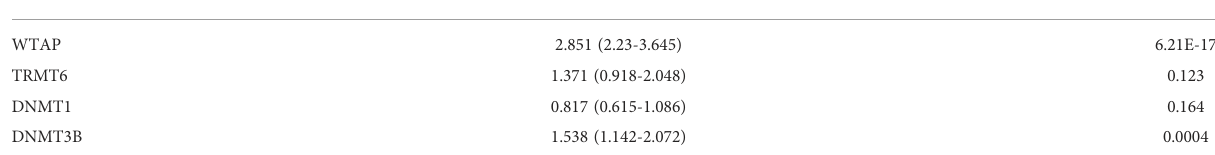
TABLE 4 Multivariate